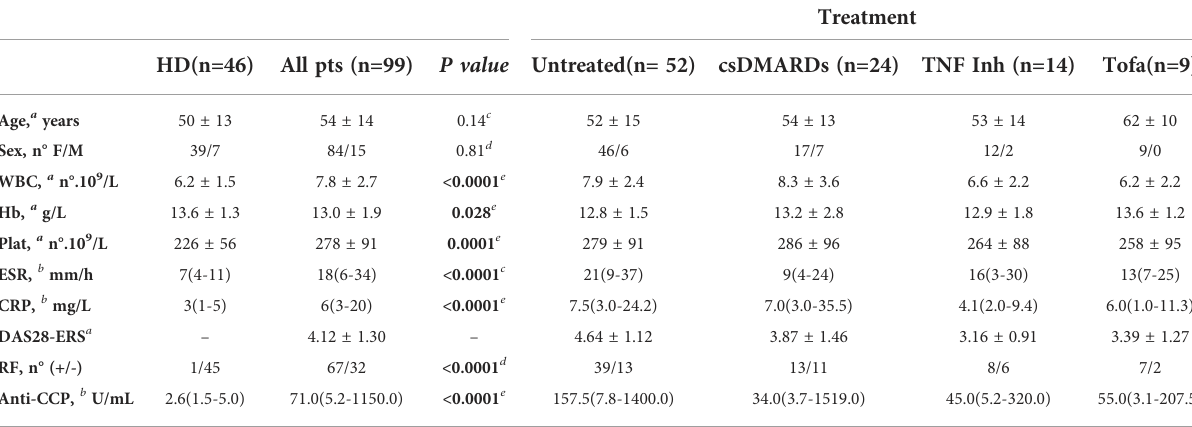
TABLE 1 Demographic and clinical characteristics of RA patients and healthy